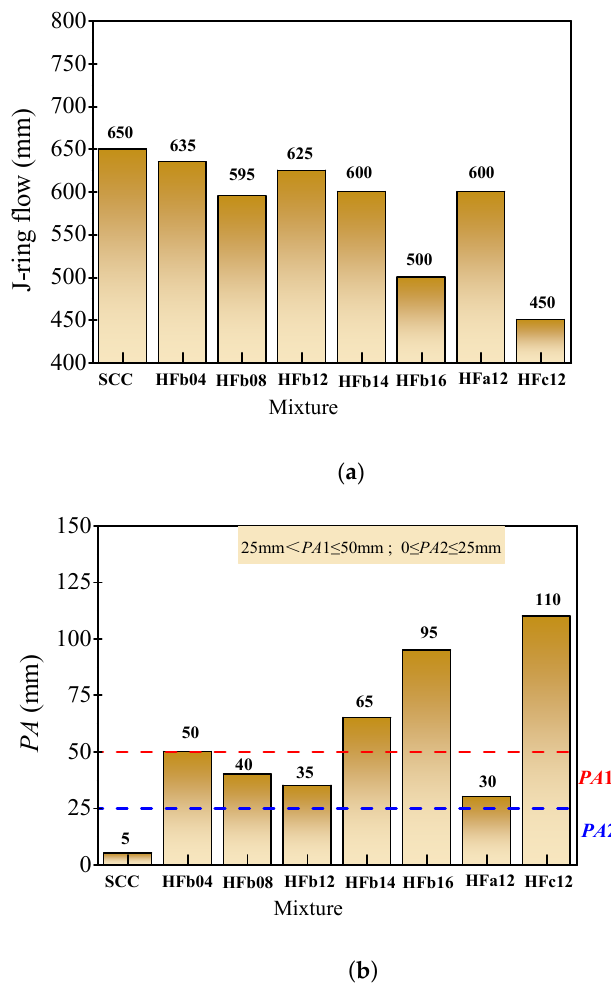
Figure 5. Test results and the corresponding performance level of passing ability. ( a ) J-ring flow. ( b ) PA.